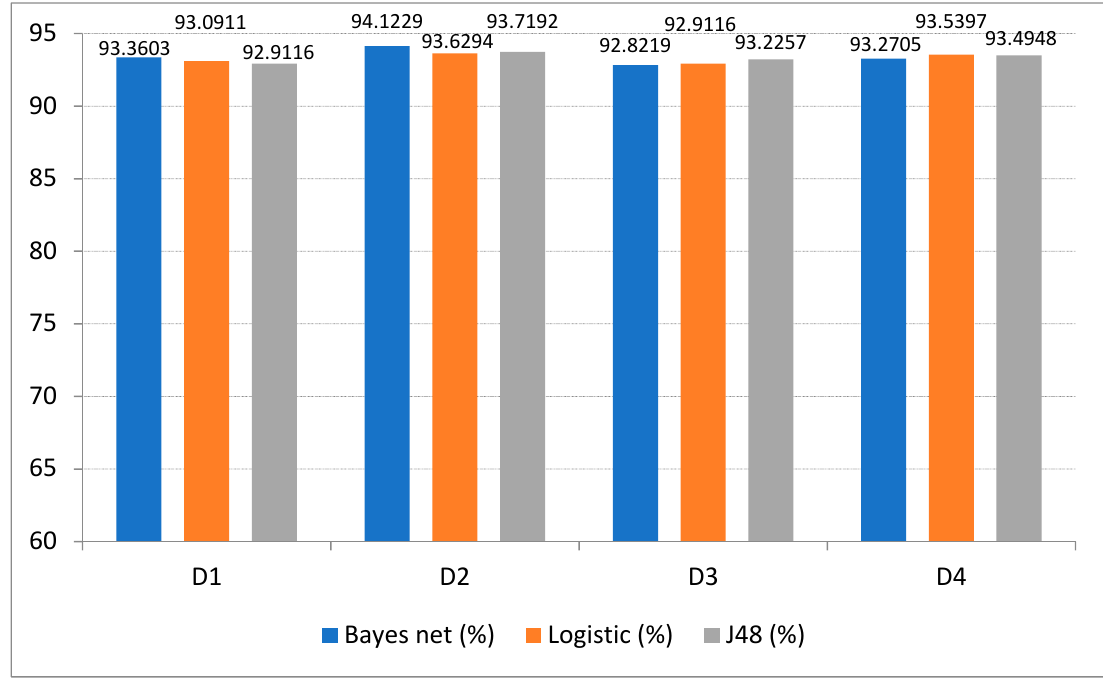
Figure 9. Models D1-D4 new store selection decision (statistical graph). Results of Experiment 4: